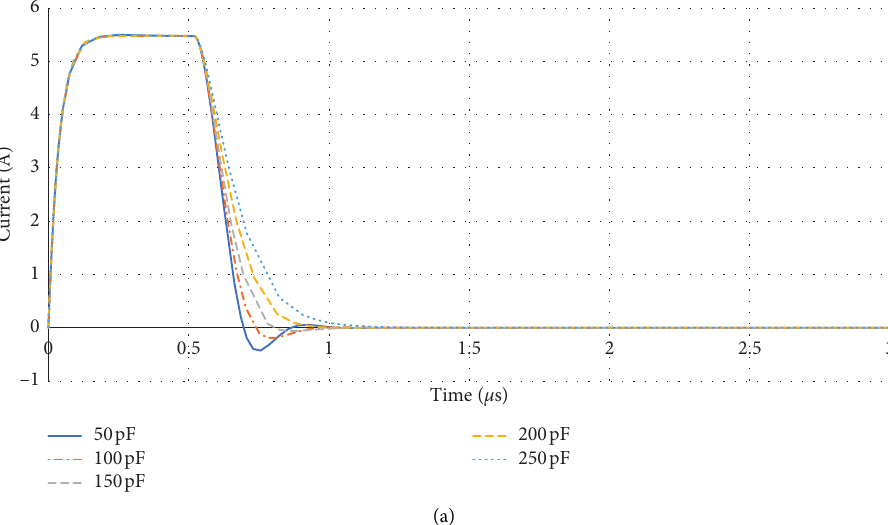
Figure 8: Switching dynamics of MOSFET influenced by L